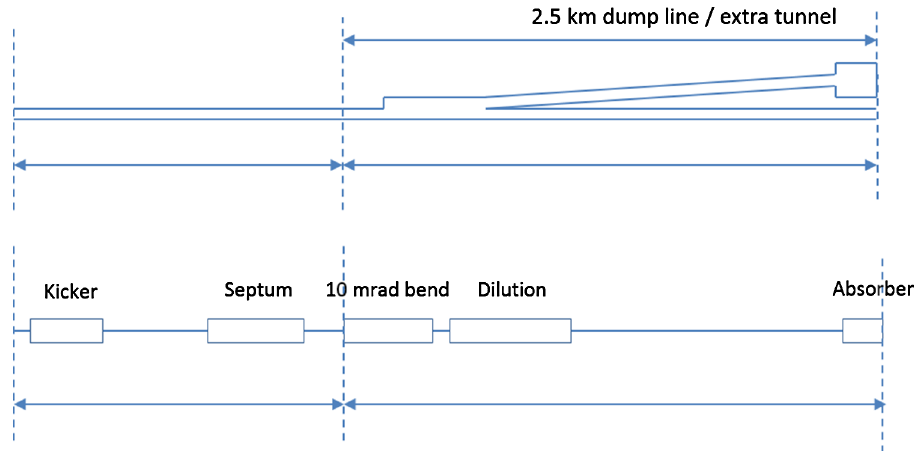
FIG. 9. Sketch of a dump tunnel separated from the arc.